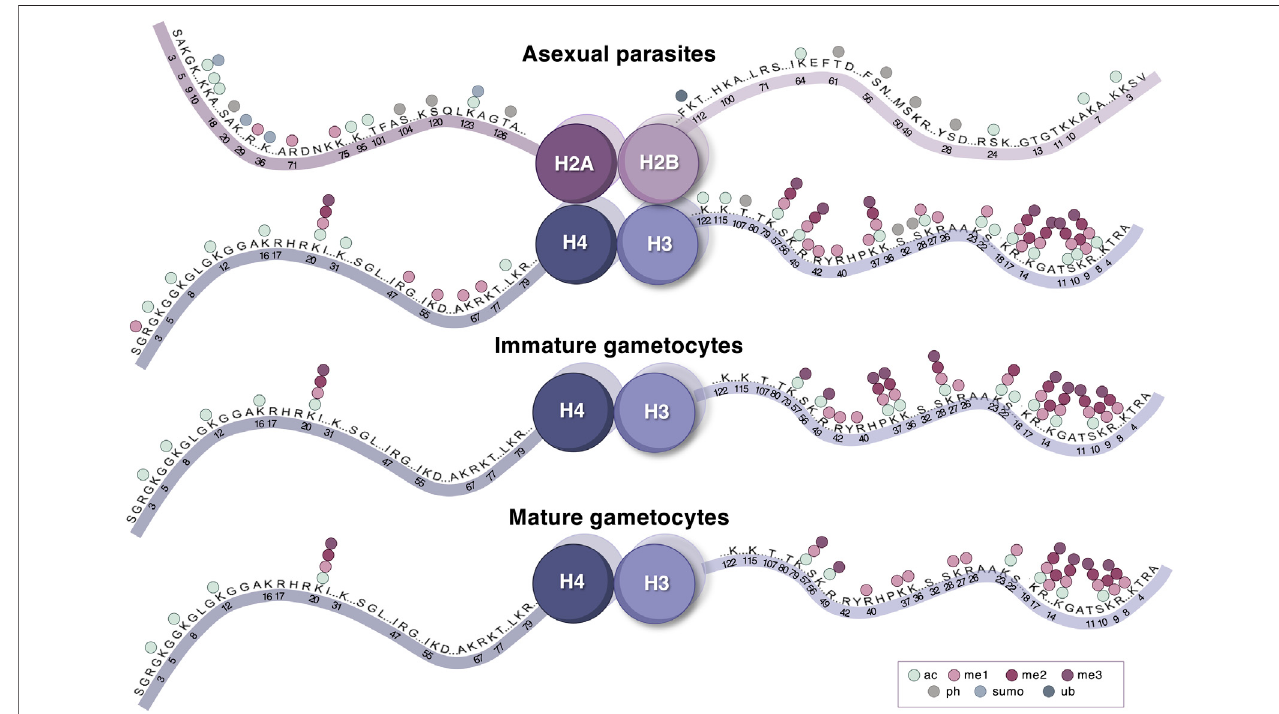
FIGURE 3 | The histone PTM landscape of P. falciparum parasites. Histone PTMs (acetylation, different levels of methylation, phosphorylation, SUMOylation, and ubiquitination) are indicated on all positions for the four histones where quantitative detection has been described. This is presented across three life cycle stages — asexual parasites, immature and mature gametocytes. Image was created with BioRender.com.